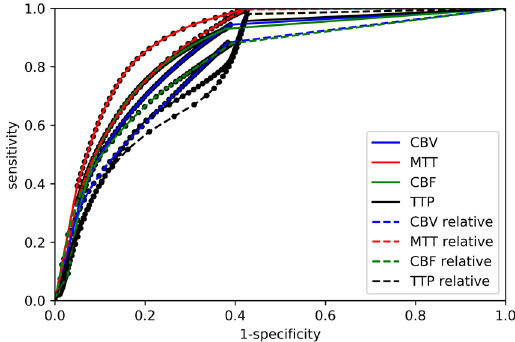
Figure 4. ROC curves regarding prediction of FIV (group A) using ATS. CBV = cerebral blood volume. MTT = mean transit time. CBF = cerebral blood flow. TTP = time to peak.